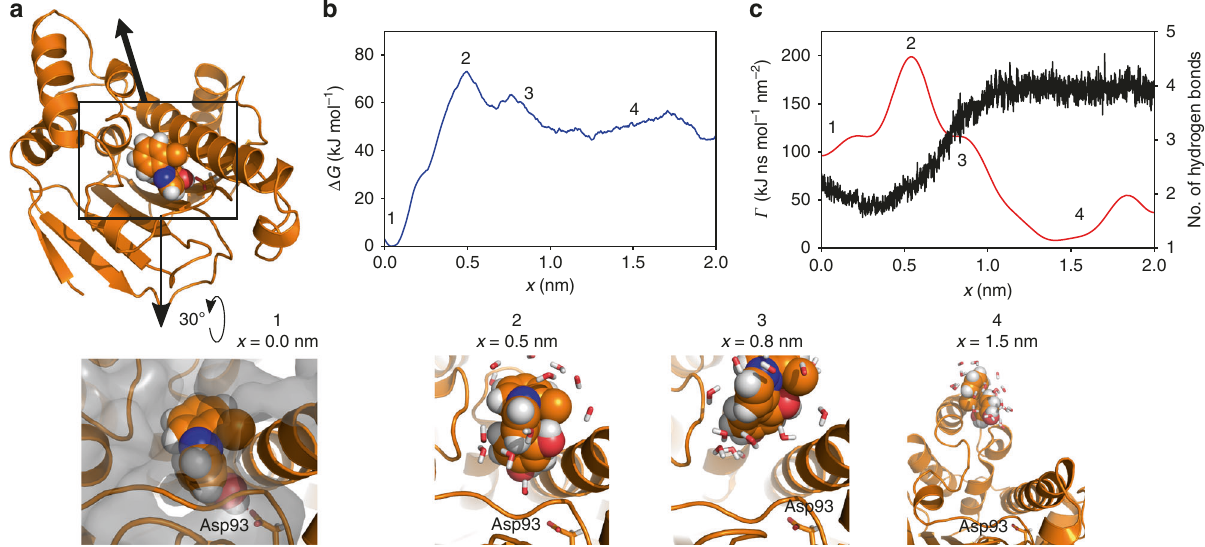
Fig. 4 Unbinding of an inhibitor from the N-terminal domain of Hsp90. a Structural evolution along the dissociation pathway in Hsp90, showing protein surface in gray, inhibitor as van der Waals spheres, Asp93 and water molecules as sticks. The inhibitor is bound to the protein in a cleft of the protein surface via a hydrogen bond to Asp93. dcTMD calculations of b free energy Δ G ( x ) and, c (Gaussian-smoothed) friction Γ ( x ) together with the mean number of hydrogen bonds between inhibitor and water. Highlighted are the bound state 1, transition state and state with maximal friction 2, an additional state with increased friction 3 and the unbound state 4. Error bars of free energy and friction estimates are given in Supplementary Fig. 2. Fluctuations of Γ ( x ) for x ≳ 1 nm are due to noise. Color code as in Fig.